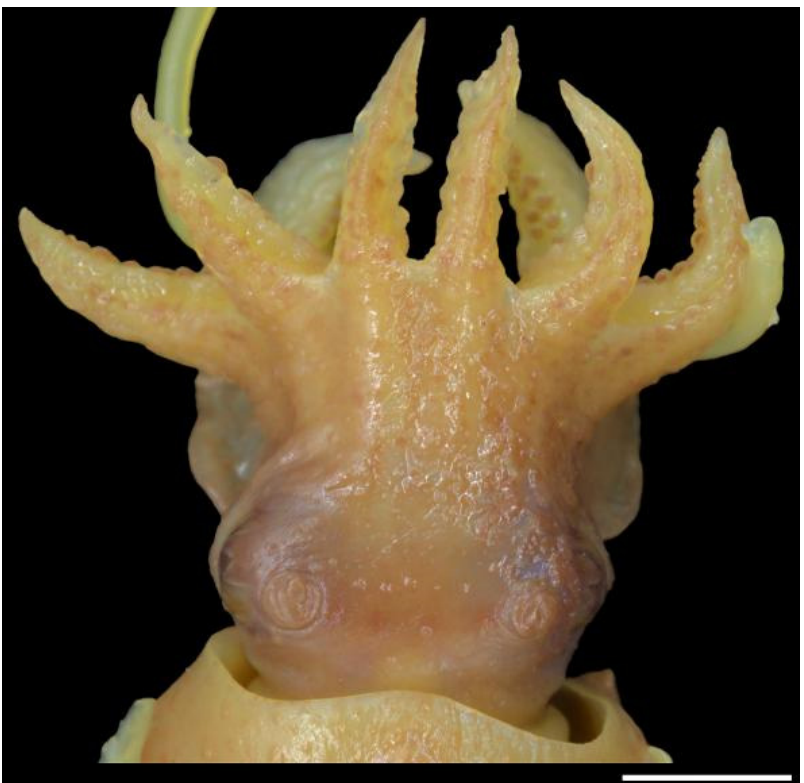
Figure 10. Dorsal view of head of. Sepia typica (SAIAB 211535 male ML 22 mm) showing prominent supra-orbital papillae and many small tubercles on the head and arms. Scale bar 5 mm.